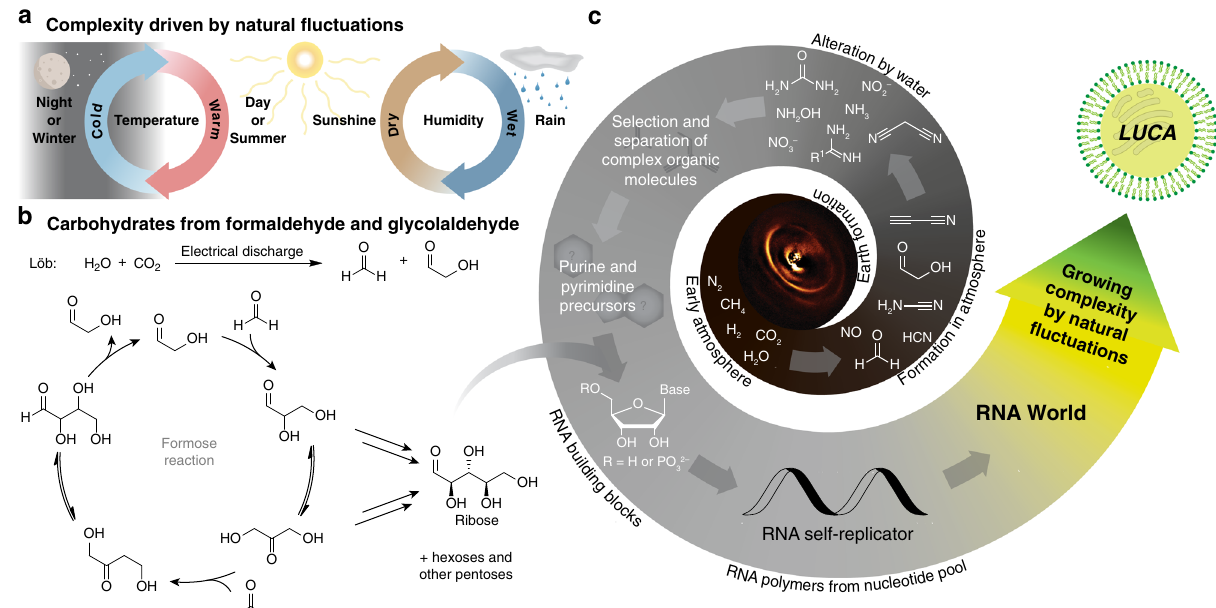
Fig. 2 Natural fl uctuations steer chemical transformations towards greater complexity. a Molecular complexity driven by fl uctuations of physico-chemical conditions, such as day – night or seasonal changes, leading to wet – dry cycles. b Since the early Earth was not uniform, carbohydrates could have emerged separately from nucleobases or their precursors e.g. via the formose reaction. c When washed into the same environment, different nucleosides/ nucleotides could have